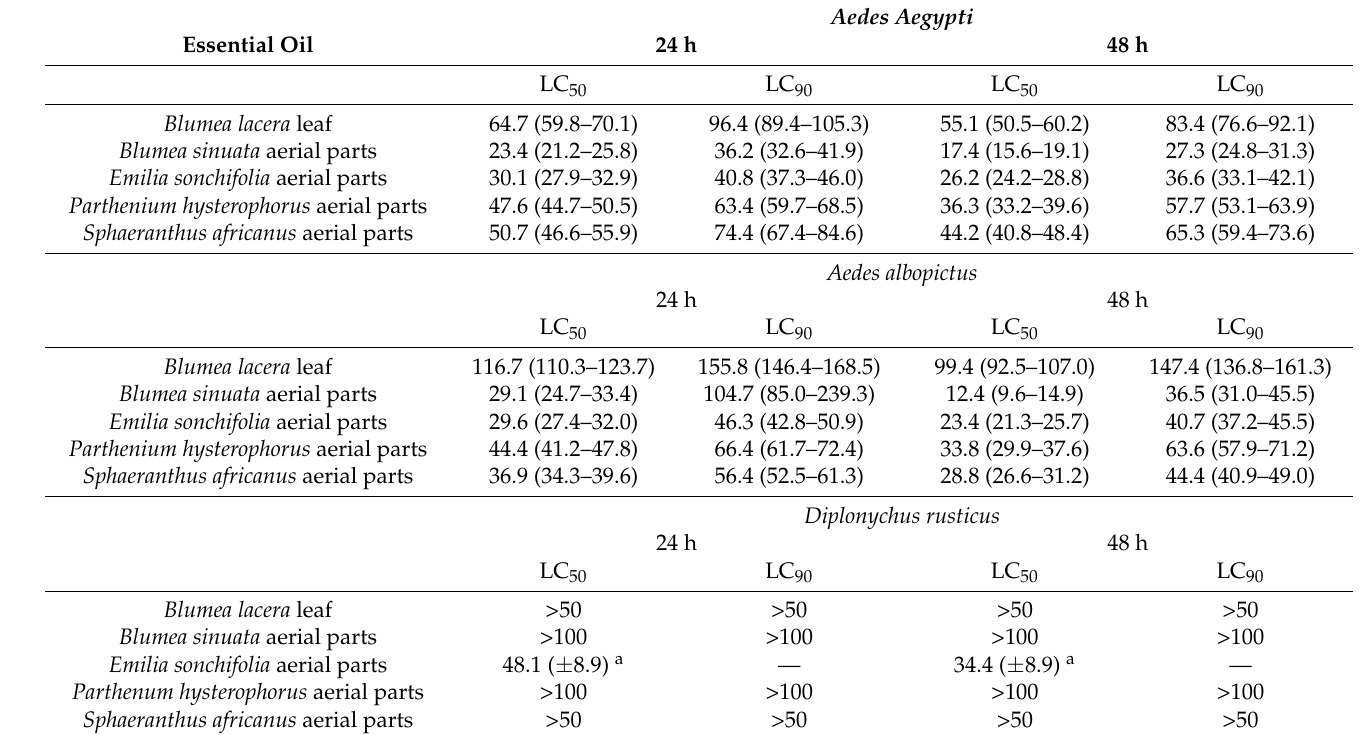
Table 6. Aedes larvicidal and Diplonychus rusticus insecticidal activities of Vietnamese Asteraceae essential